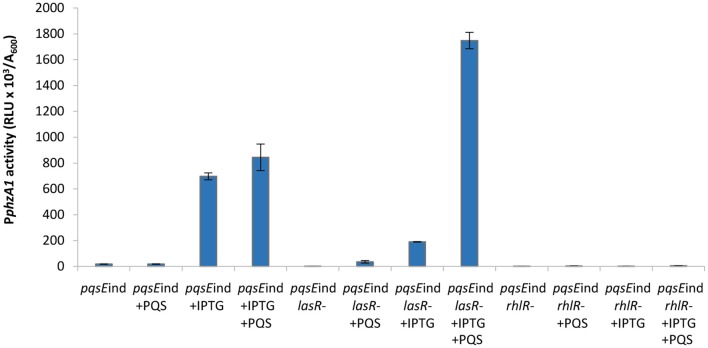
PQS is unable to induce high levels of PphzA1 transcription in the absence of PqsE or RhlR. Maximal promoter activity of PphzA1-lux in the pqsEind strain and pqsEind strain carrying additional lasR or rhlR mutations in the presence or absence of IPTG and PQS. Promoter activities are normalized by cell density (A600).